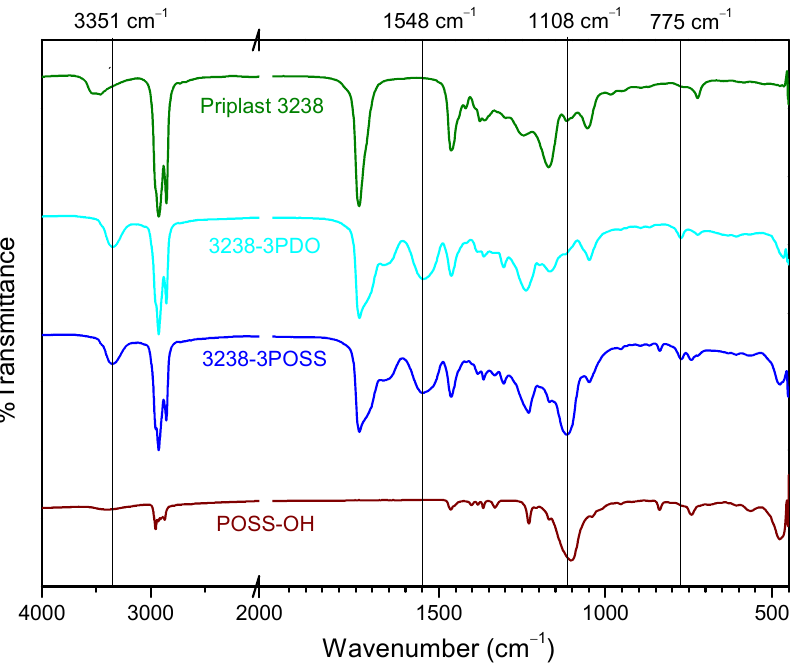
Figure 5. FTIR spectra of (from top to bottom): Priplast 3238, 3238-3PDO, 3238-3POSS, and pure POSS-OH.